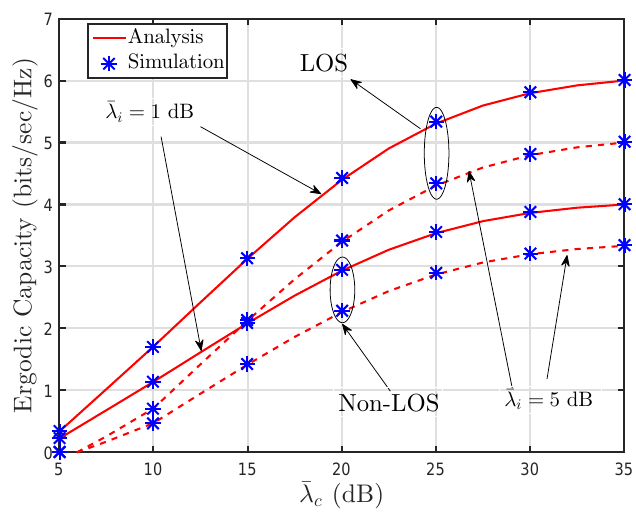
Figure 3. Ergodic capacity as a function of ¯ λ c